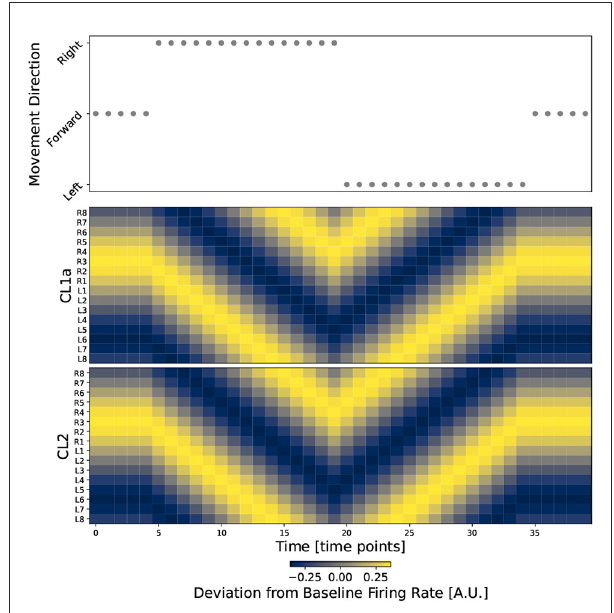
FIGURE7 The circuit successfully integrates direction information into the heading signal. The top plot shows movement direction at discrete time points during a simulated walk. The two bottom plots show the firing rates of all CL1a and CL2 neurons in Model d , respectively. Neurons are indexed and arranged by their corresponding columns of the PB, revealing one activity bump along the PB in each subset of columnar